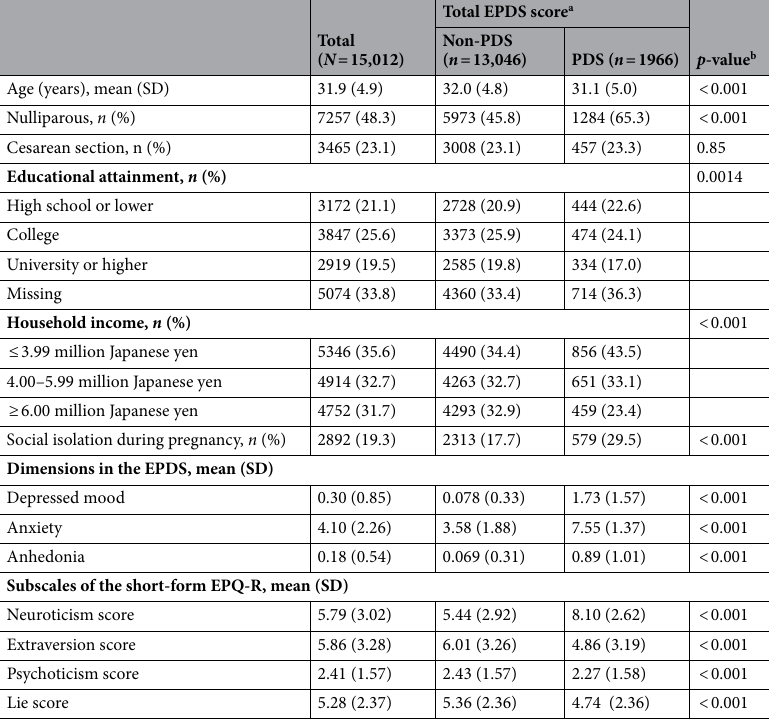
Table 1. Characteristics of participants: the Tohoku Medical Megabank Project Birth and Three-Generation Cohort Study. EPDS, Edinburgh Postpartum Depression Scale; EPQ-R, Eysenck Personality Questionnaire- Revised; PDS, postpartum depressive symptoms; SD, standard deviation. a Total EPDS score was dichotomized into non-PDS (score ≤ 8) and PDS (score ≥ 9). b Obtained using Student’s t -test for continuous variables and the chi-square test for categorical variables, comparing non-PDS and PDS groups.